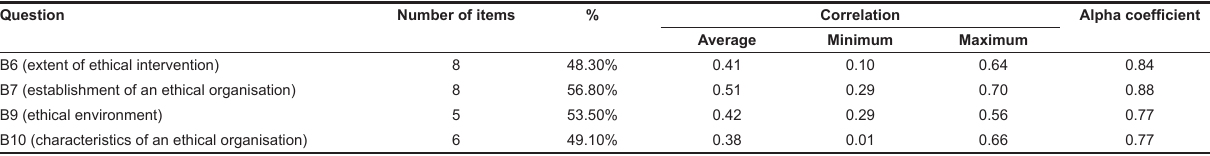
TABLE 1 Principal component analysis: ethics interventions and characteristics of ethical organisations